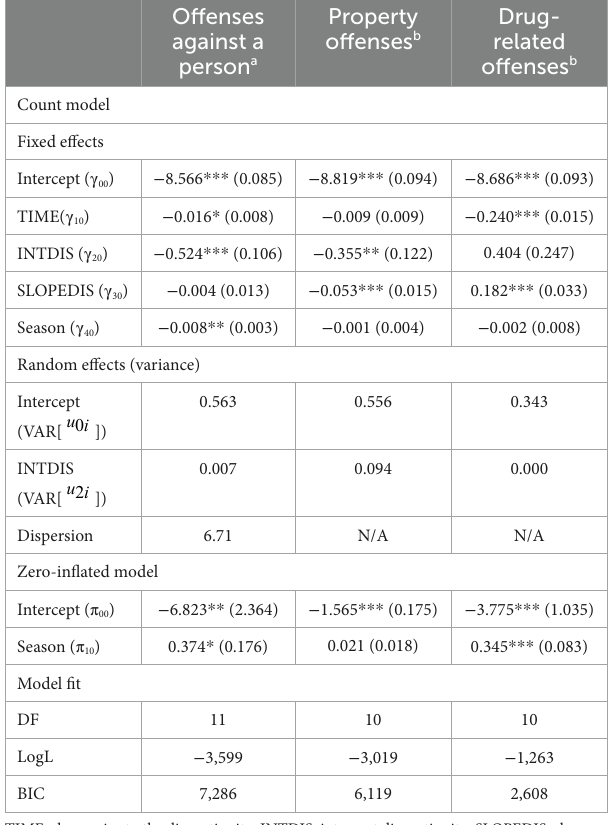
TIME, slope prior to the discontinuity; INTDIS, intercept discontinuity; SLOPEDIS, slope discontinuity; VAR, variance; DF, degrees of freedom; LogL, log likelihood; BIC, Bayesian information criterion. a Zero-inflated negative binomial model.